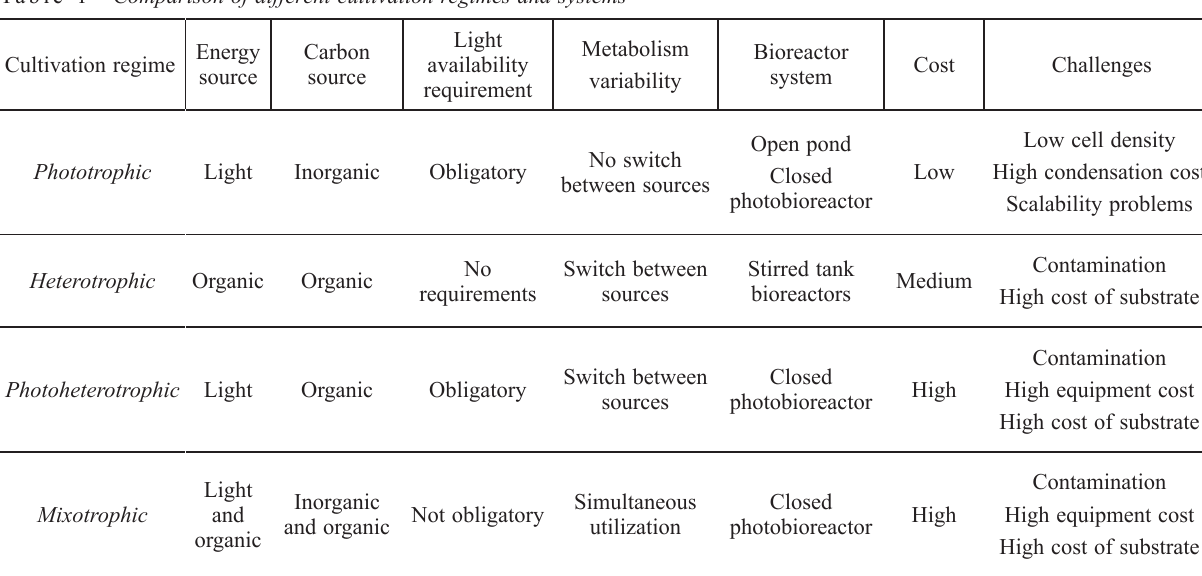
Table 1 – Comparison of different cultivation regimes and systems Energy Cultivation regime